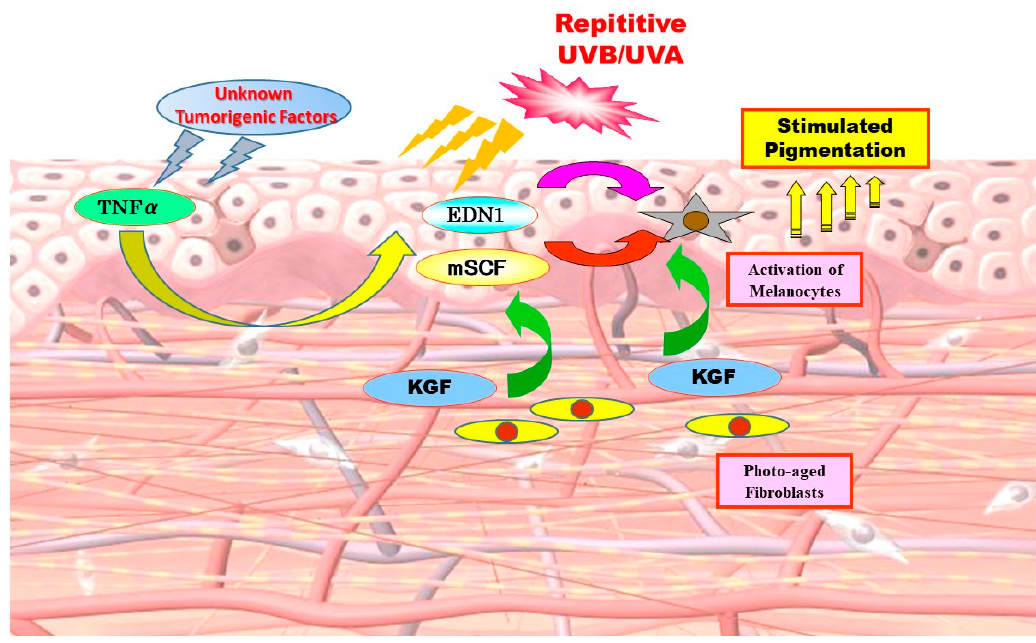
Figure 5. The biological sequence for the hyperpigmentation mechanism involved in SLs [2,4,8,25].